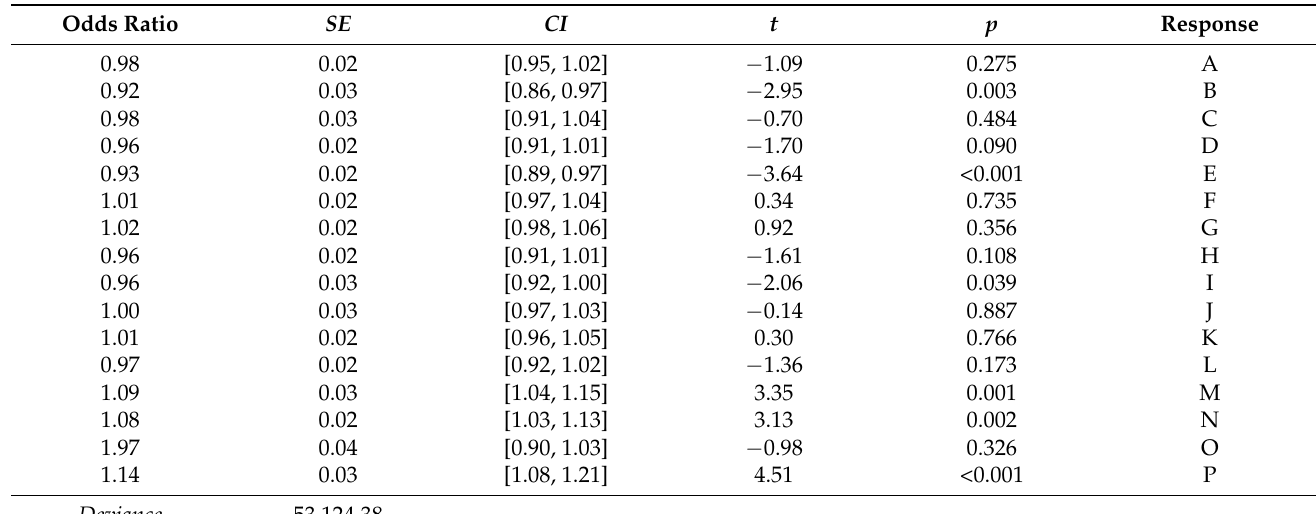
Table A17. Emospace widget response multinomial logistic regression model for conscientiousness concerning the space of a widget as